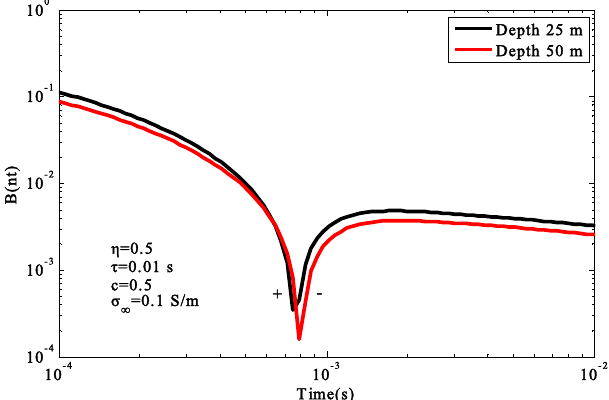
13 of 16 Figure 14. The response curves under different offset distances. Based on Figure 12, flight altitude mainly affected the amplitude of the response. The effect on the time of sign reversal was not obvious, and the sign reversal phenomenon was mainly concentrated in the range 1.5–2 ms. With the increase in flight altitude, the received electromagnetic response decreased gradually. It can be seen from Figure 13 that the length of the emission source mainly affected the amplitude of the response. The length of emission source increased gradually, and the amplitude of response increased gradually, which also shows that a longer emission source resulted in a higher resolution of the polarizable body. In Figure 14, with the decrease in offset distance, the time of the sign reversal appeared earlier, and the polarization response became easier to observe at a short offset distance. Next, we set the air layer conductivity to